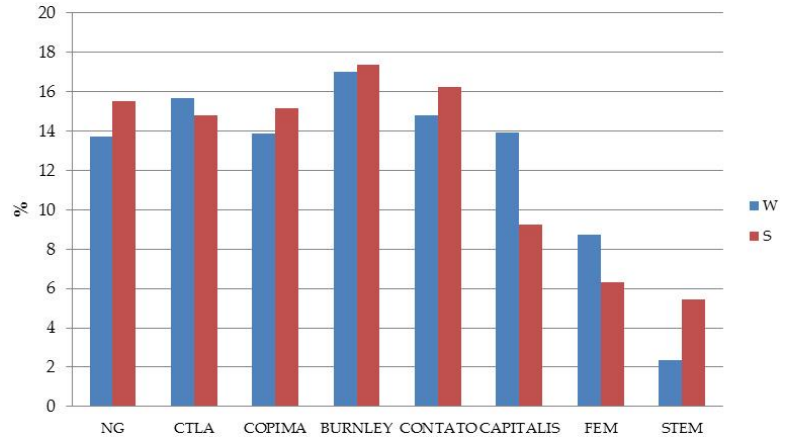
Figure 2. Percentage of methods selected according to season .